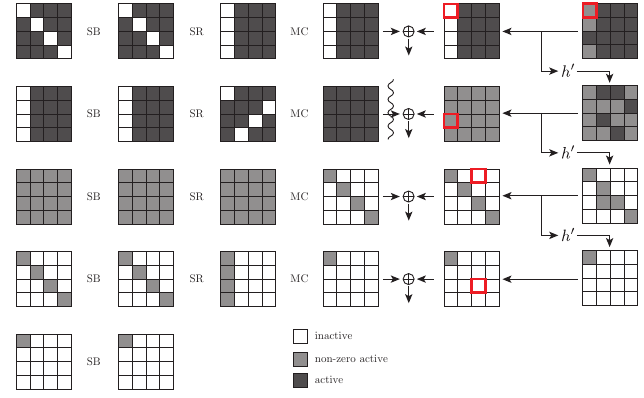
Figure 11: Zero-correlation linear hull on the toy cipher.